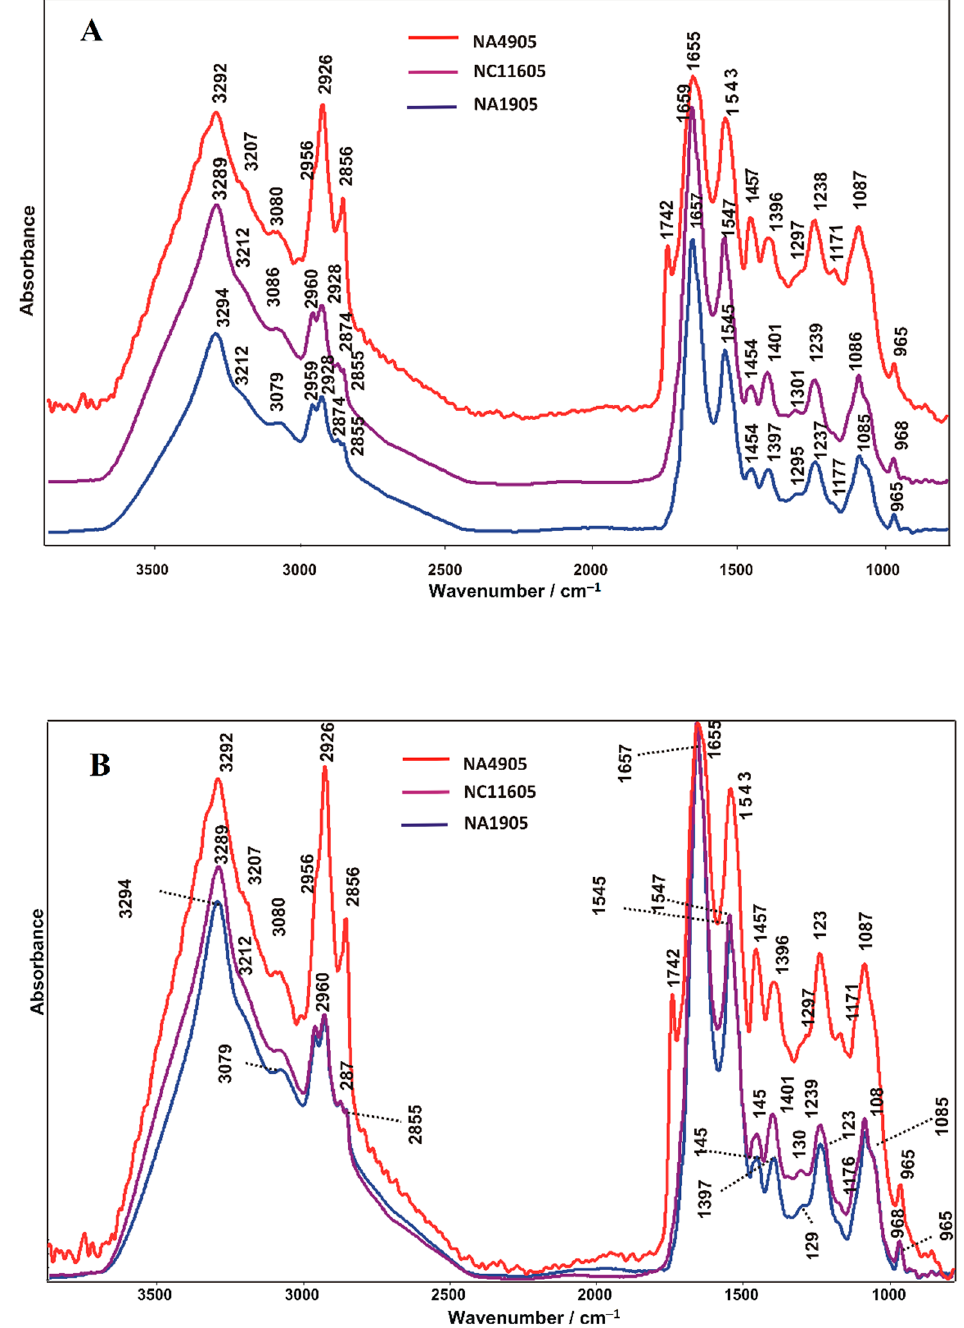
Figure 3. The relative intensity FT-IR spectra of NA4905 (control), NC11605, and NA1905 (pathologi- cally altered rainbow trout kidney tissues) with band assignments—( A ). FT-IR spectra normalized to the highest intensity band—amide I ( B